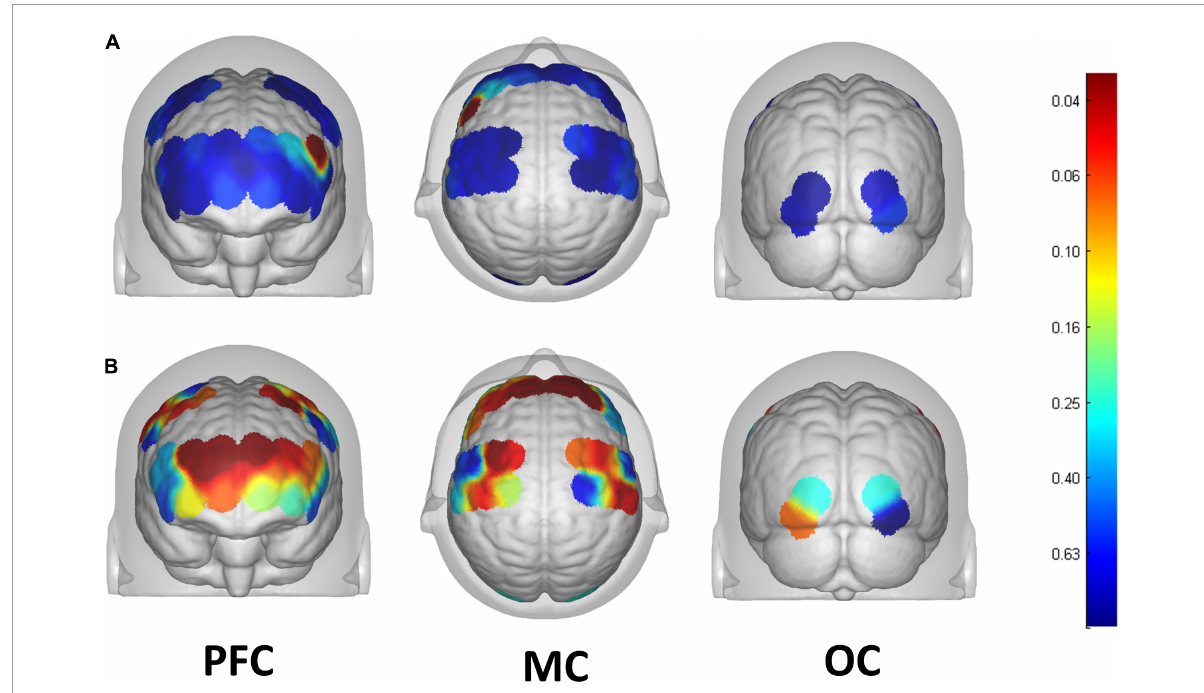
FIGURE3 Brain map of activation regions during FNS by using beta values of GLM analysis in the (A) HCs, and the (B) stroke patients. The color bar represents the P -value of beta